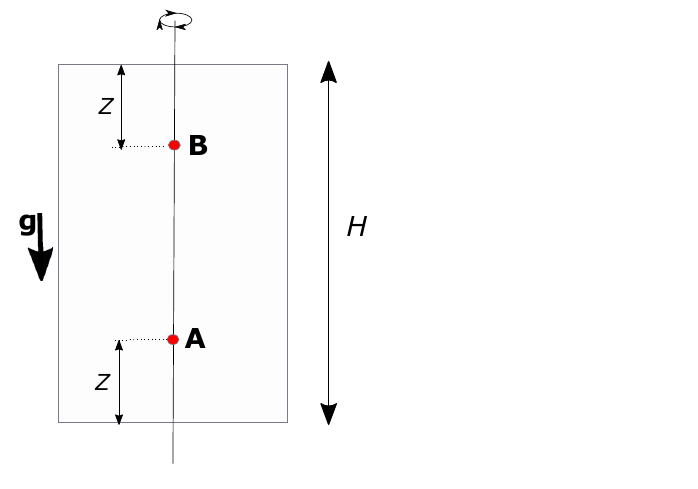
Figure 2. Vertical cross-section through the experimental setup, with cylinder axis in the middle.